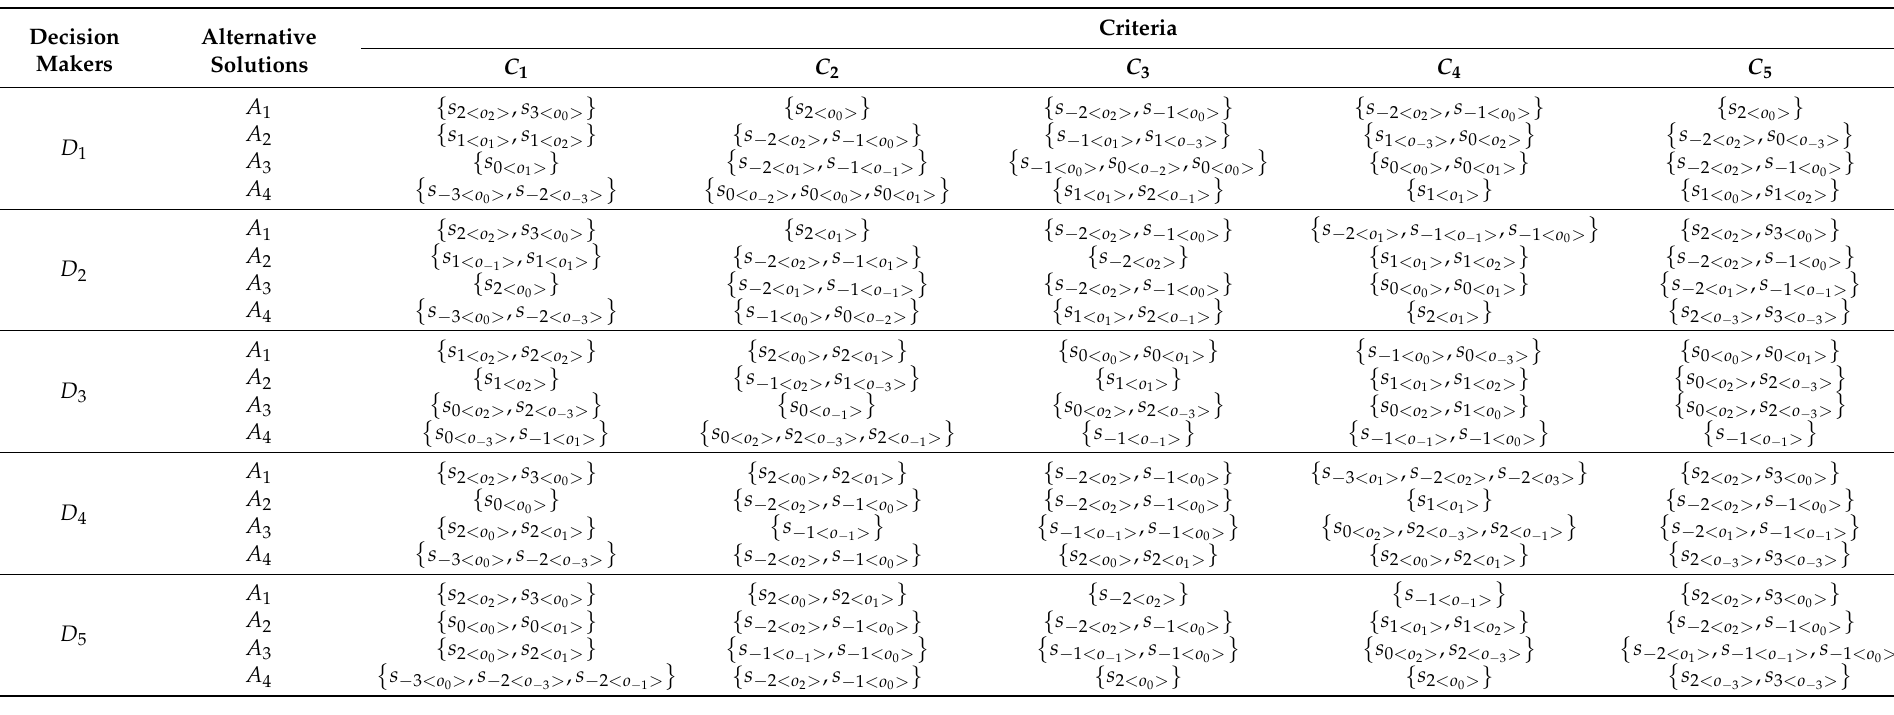
Table 1. DHHL decision matrices given by the decision makers.